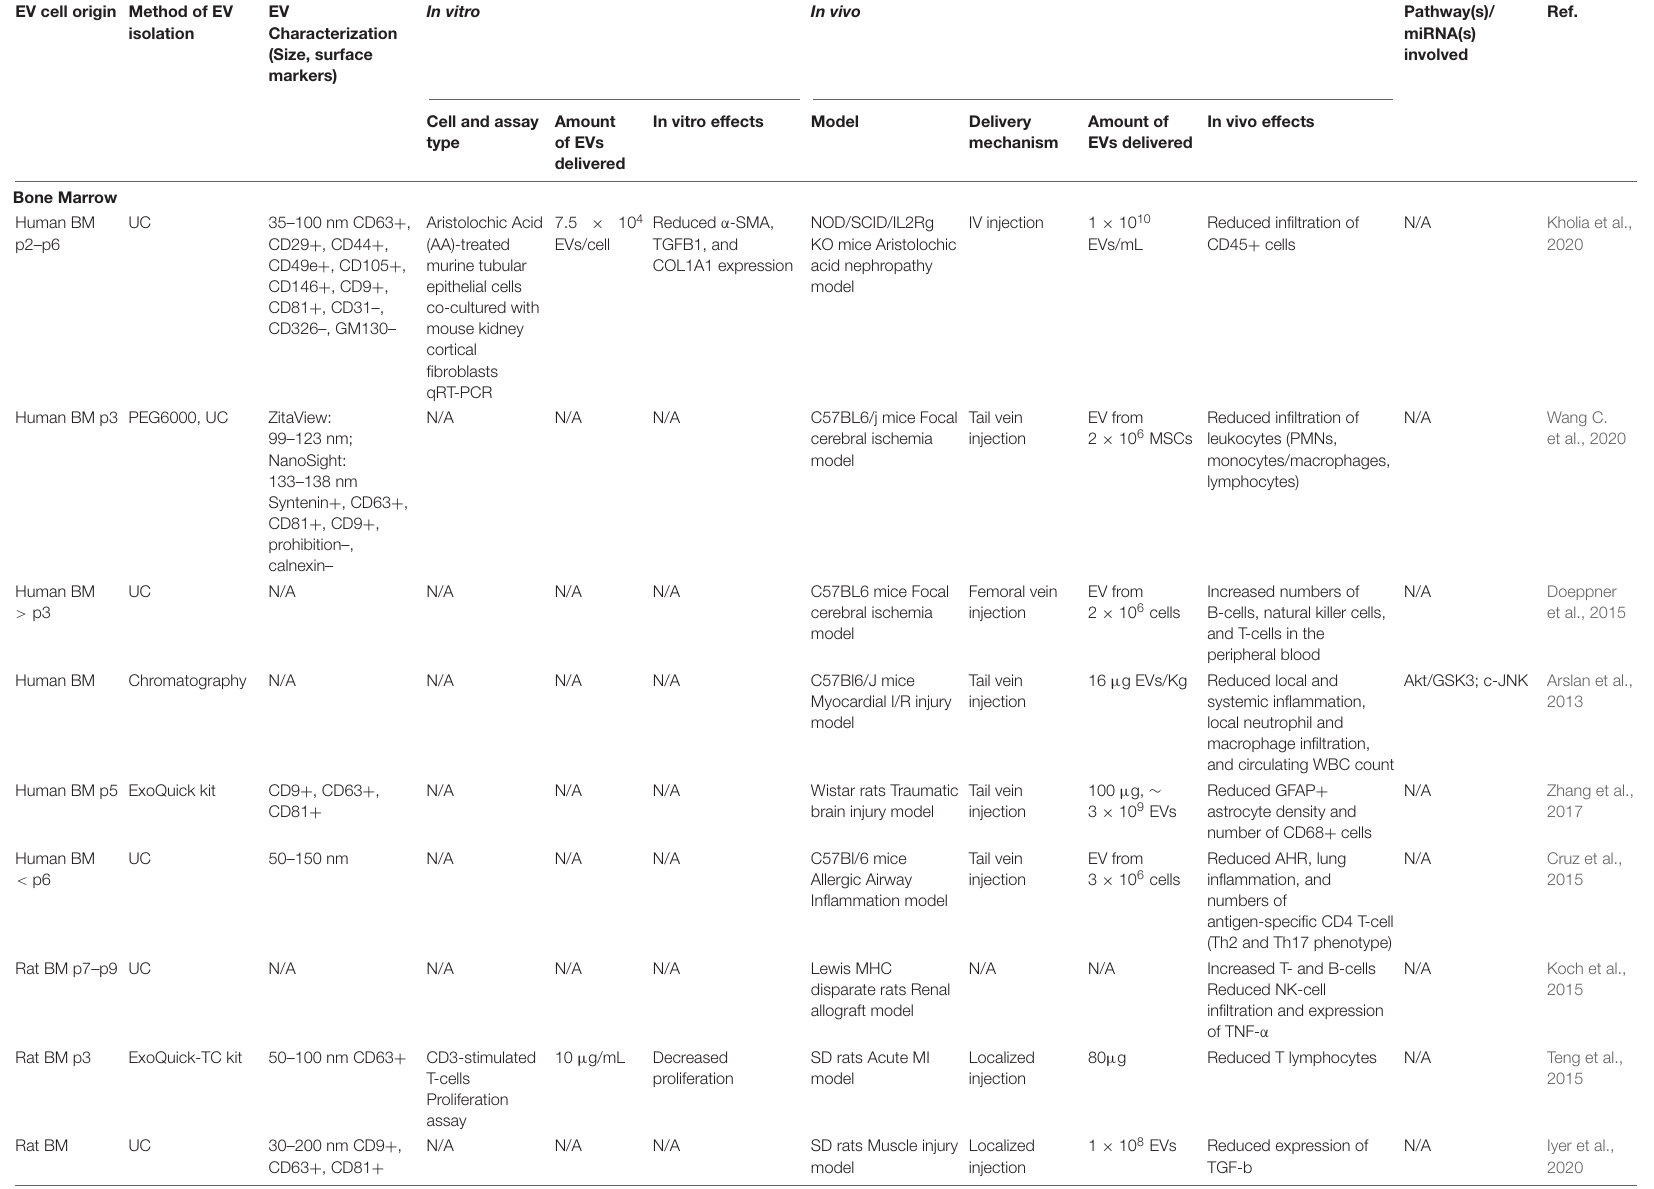
TABLE 5 | Preclinical studies employing BMMSC- and ADMSC-derived EVs to induce